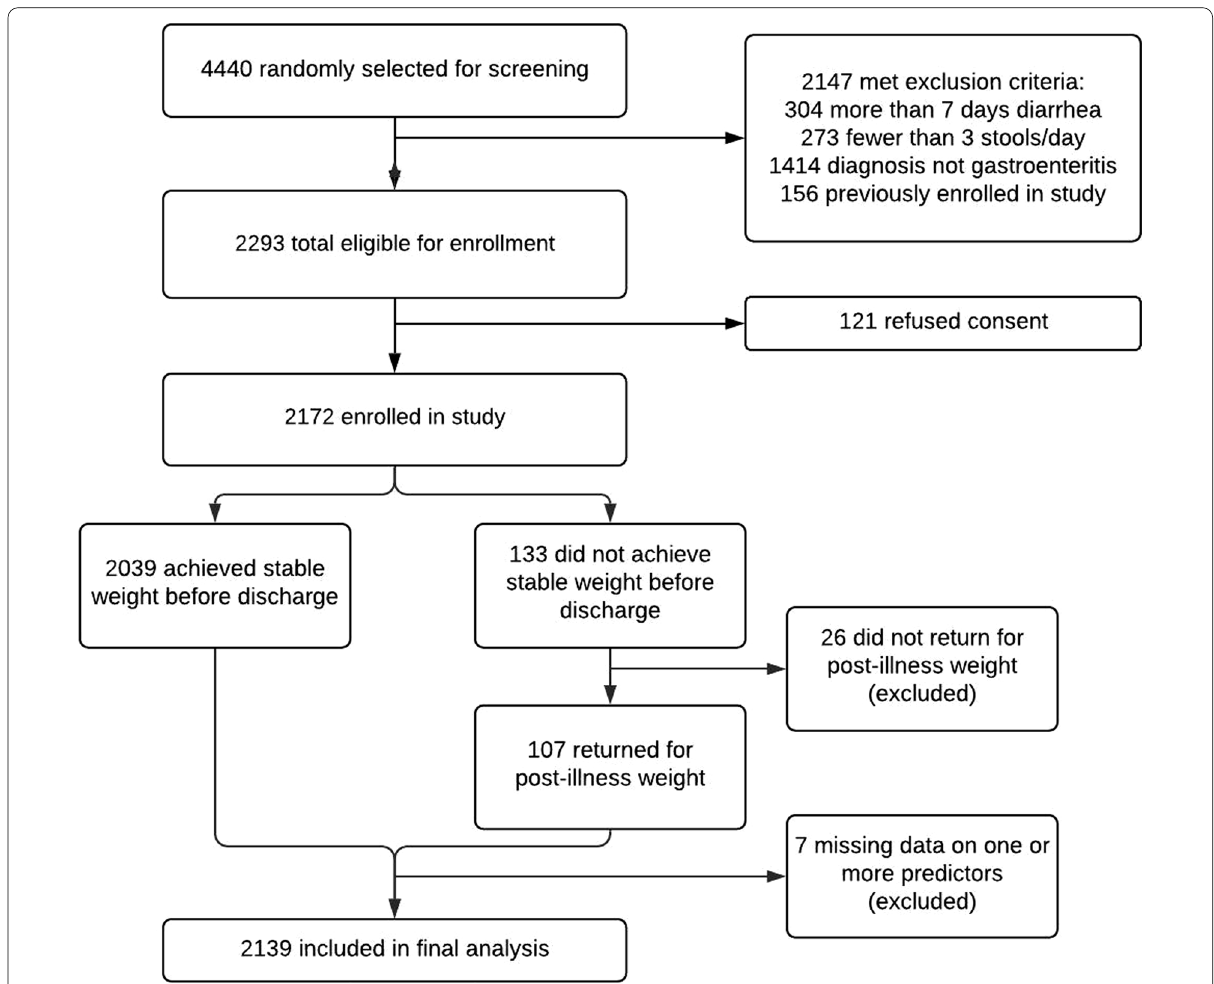
Fig. 2 NIRUDAK enrollment